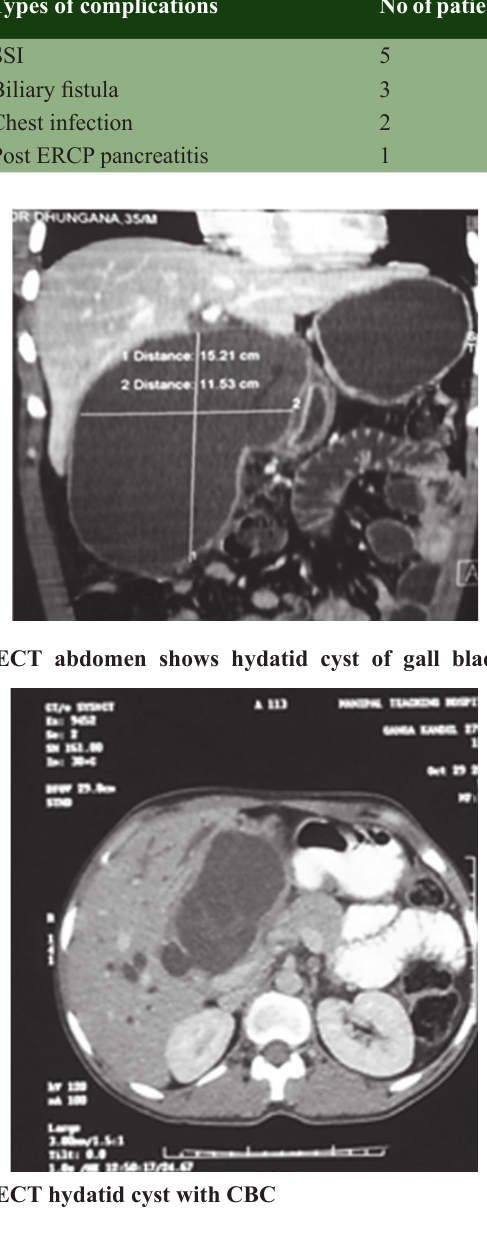
Table 2.Total no. of complications Types of complications No of